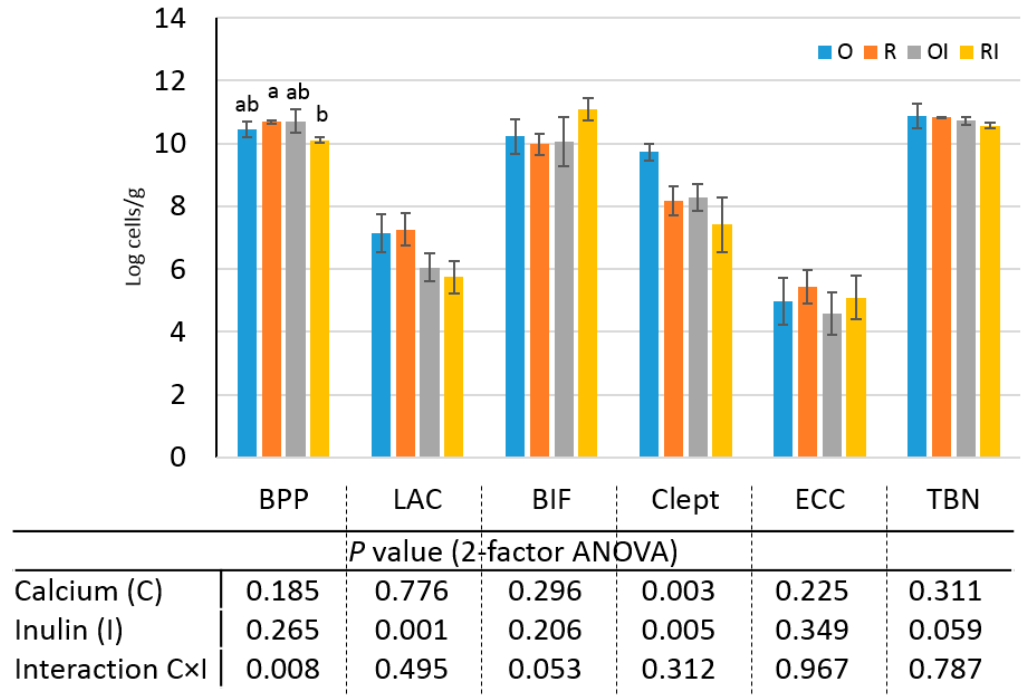
Figure 1. Counts of Bacteroides-Prevotella-Porphyromonas (BPP), Lactobacillus (LAC), Bifidobacterium (BIF), Clostridium leptum group (Clept), Enterococcus (ECC) and total bacterial number (TBN) of caecal microbiota of rats fed the experimental GFDs. Values are expressed as means ± standard deviation; O, group fed a GF diet with the recommended calcium content; R, group fed a GF diet with restricted calcium content; OI, group fed a GF diet with the recommended calcium content and inulin; RI, group fed a GF diet with restricted calcium content and inulin. Significant differences between groups O, R, OI and RI are indicated with superscripts only when C × I interactions were statistically significant ( p < 0.05).